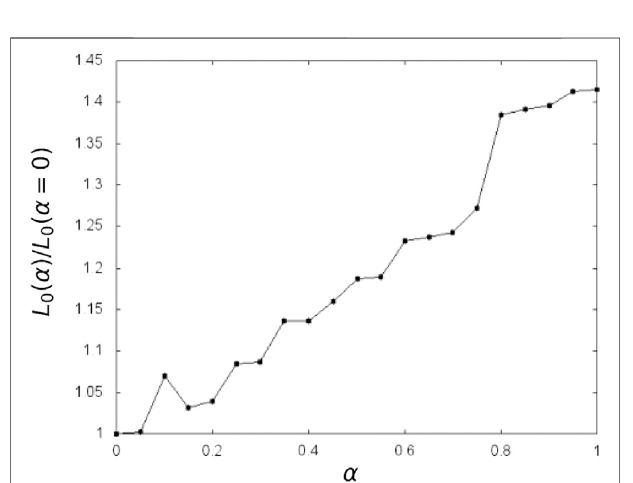
FIGURE 4 | The length of the optimal paths, L O between the lower left and upper right corner of III as a function of α , while keeping β (cid:3) 0.